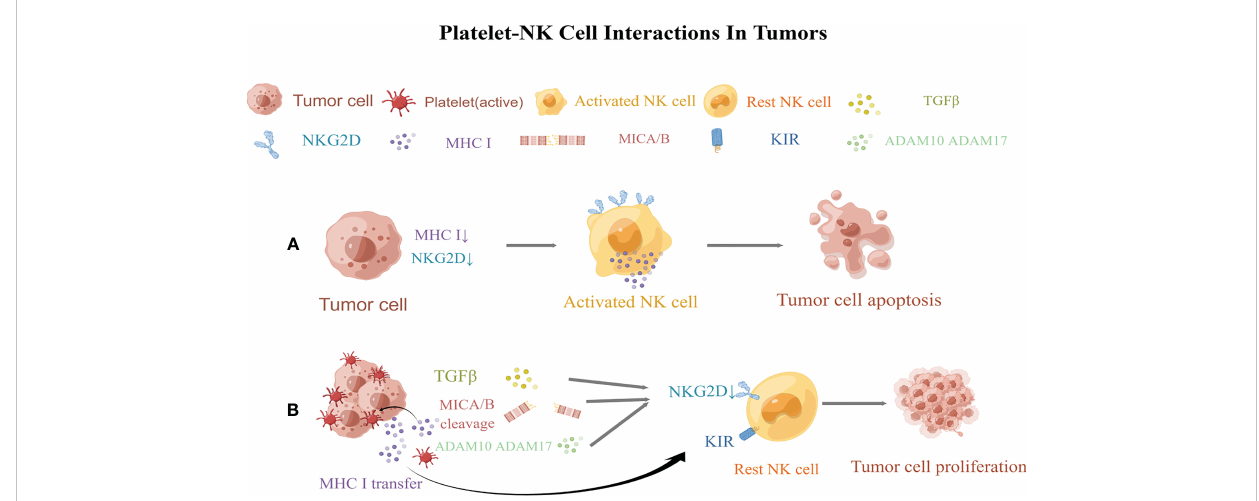
FIGURE 2 Regulation of natural killer (NK) cellsl responsiveness by platelets. (A) Normal NK cells kill tumor cells via the “ missing self ” and “ induced self. ” (B) Platelets obstruct NK cells, allowing tumor cells to proliferate by evading immune surveillance. Activated platelets then wrap around tumor cells, promote the transfer of MHC class I molecules to the surface of cancer cells, and decreases the “ missing self ” recognition of abnormal cells by NK cells. Platelets then reduce the expression of MICA and MICB on tumor cells and impair the “ induced self ” recognition of NK cells. Moreover, platelets also express the enzymes ADAM10 and ADAM17, which shed NKG2D on tumor cells. In turn, platelets release TGF- b to downregulate NKG2D and induce the expression of killer cell immunoglobulin-like receptors (KIRs) on NK cells. MICA and MICB, MHC class I chain-related protein (A,B) ADAM10andADAM17, a disintegrin and metalloproteinase domain-containing protein10 and 17; NKG2D,NK group 2D; KIRs, killer cell immunoglobulin-like receptors. This fi gure is drawn by Figdraw (https:// fi gdraw.com/). The " ↓ " arrows refer to the decreased expression of MHCI and